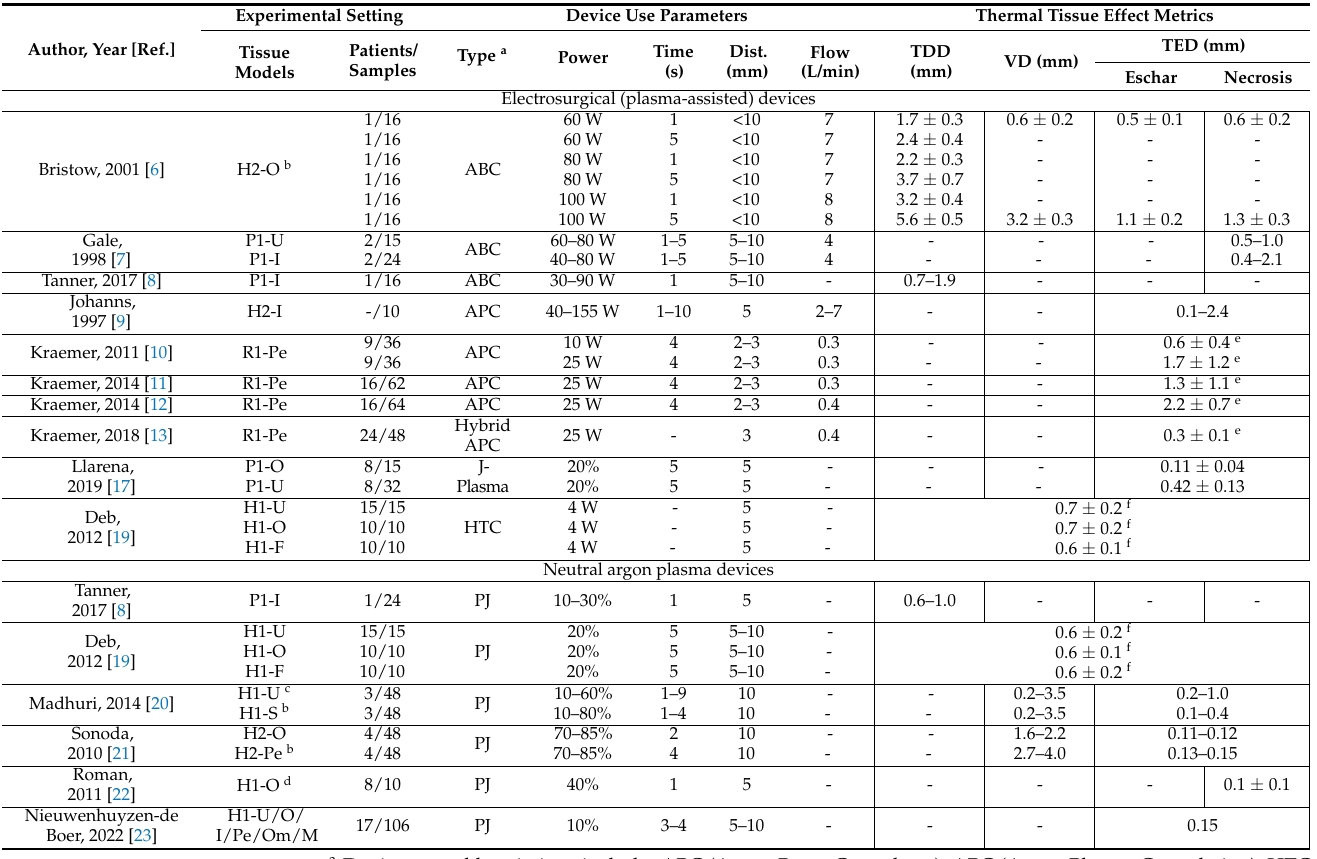
Table 2. Depth of tissue effects are reported in literature with either a range or mean ± std notation. Experimental models are annotated as: H = human, P = porcine, R = rodent, 1 = in-vivo, 2 = in- vitro/ex-vivo, O = ovary, U = uterus, F = fallopian tube, I = intestines, S = sigmoid colon, E = endometrium, Pe = peritoneum, M = intestinal mesentery and Om = omentum. Tissue effects are measured as total depth of damage (TDD), vaporization depth (VD), or thermal effect depth